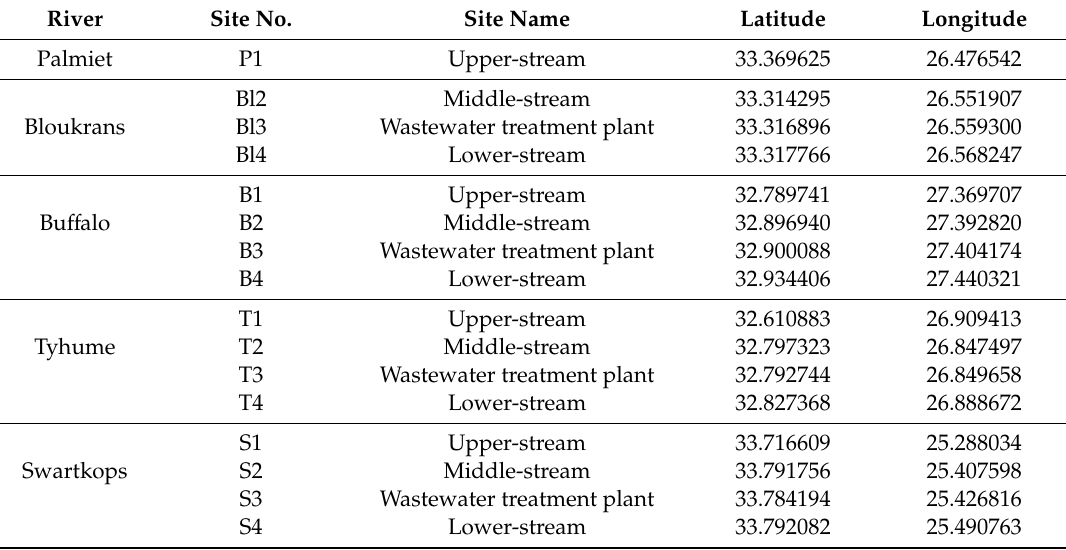
Table 1. Co-ordinates of the sampling sites of all the studied